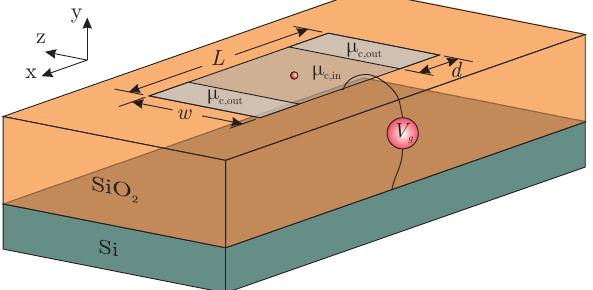
Figure 3. The proposed graphene antenna with a matching component as termination.